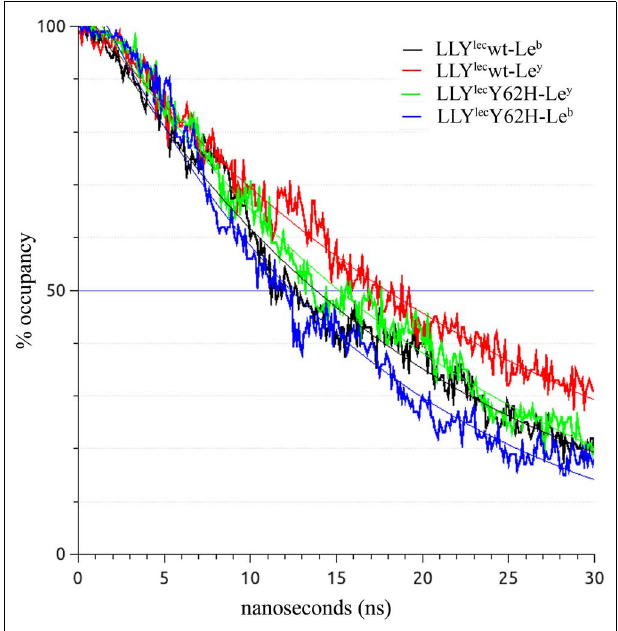
FIGURE 5 | Molecular dynamics modeling of the association of Lewis antigens with the LLY lec binding sites. Traces are averaged for all 100 simulations. Overall, the Lewis antigens occupied the binding site of either the wild-type or LLY lec Y62H less as the simulation progressed. However there are numerous areas of re-association, resulting in a spike in